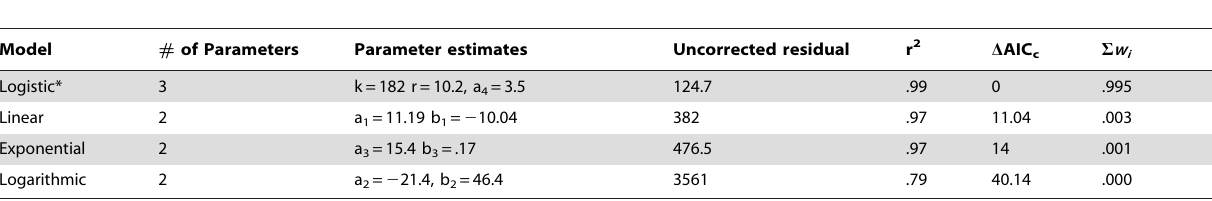
Table 1. Rate of transmission analyses using Akaike Information Criterion (*best